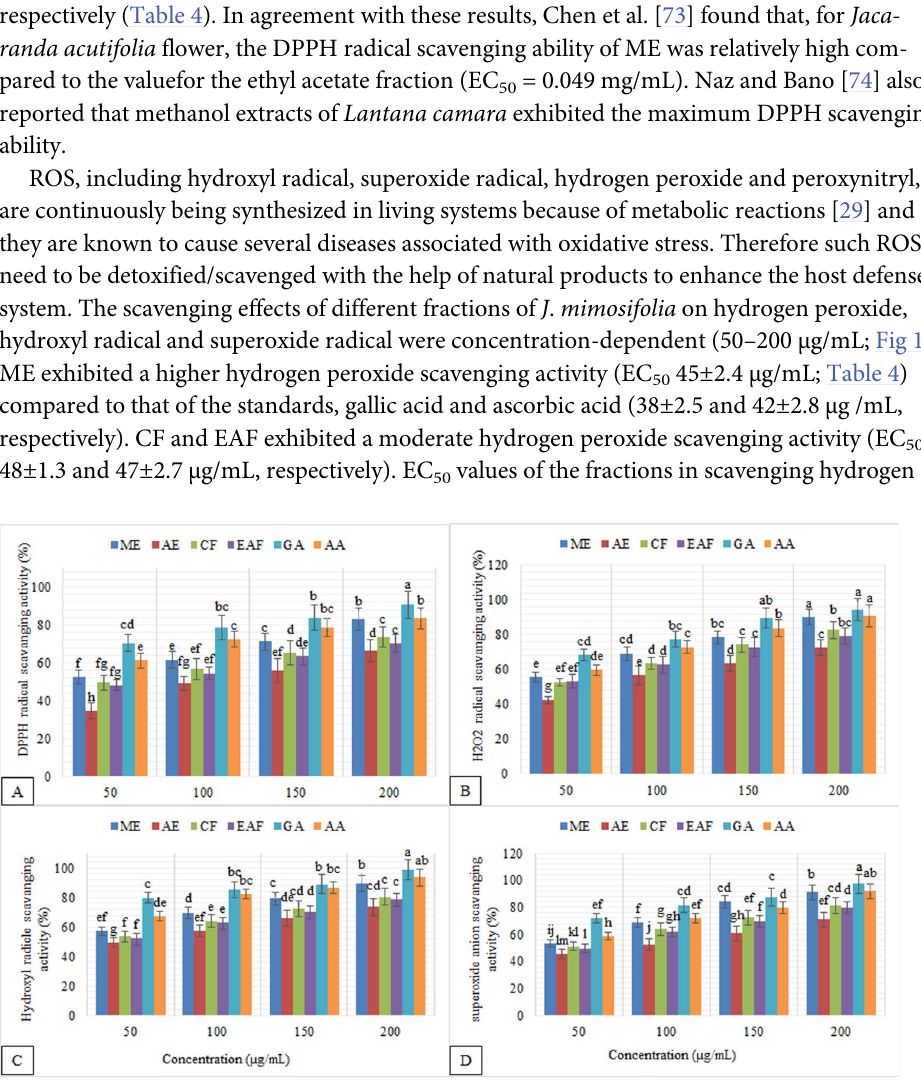
Fig 1. Antioxidant activities of J . mimosifolia leaf extracts and fractions at various concentrations. Data represent mean ± standard deviation (SD) of three biological replicates. (A) DPPH radical scavenging activity, (B) Hydrogen peroxide radical scavenging activity, (C) Hydroxyl radical scavenging activity, (D) Superoxide radical scavenging activity. GA, gallic acid; AA, ascorbic acid.